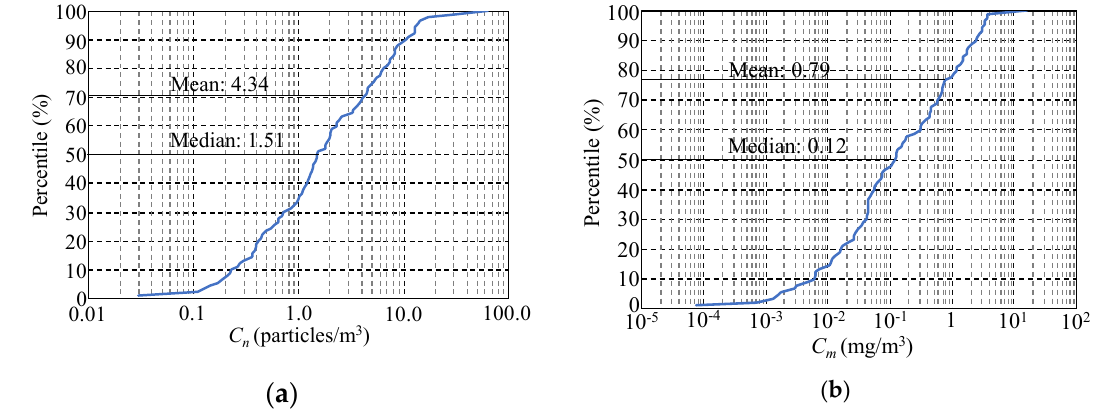
Figure 3. Percentiles of MicP numerical concentration ( a ) and mass concentration ( b ) for all data. The x-axis is displayed on a logarithmic scale.